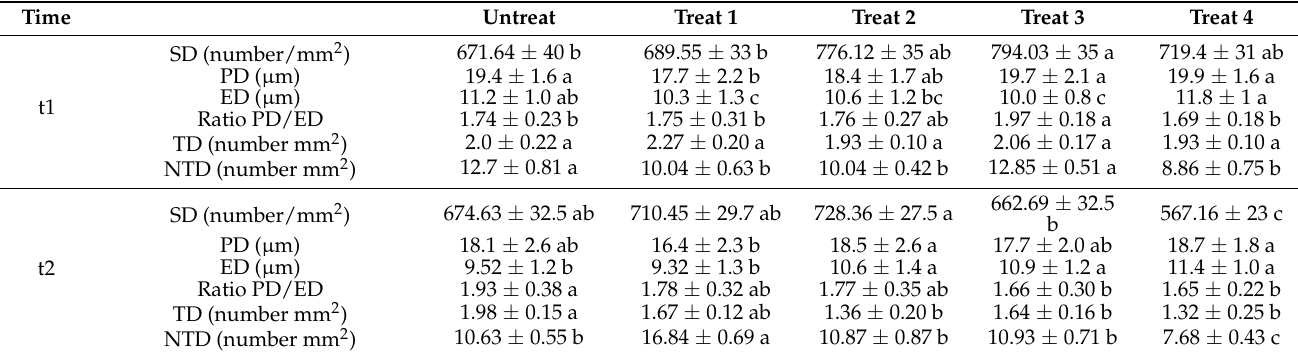
Table 5. Characteristics of hop foliar features after each treatment at each time. In column and for each parameter, different letters indicate significant differences ( p <